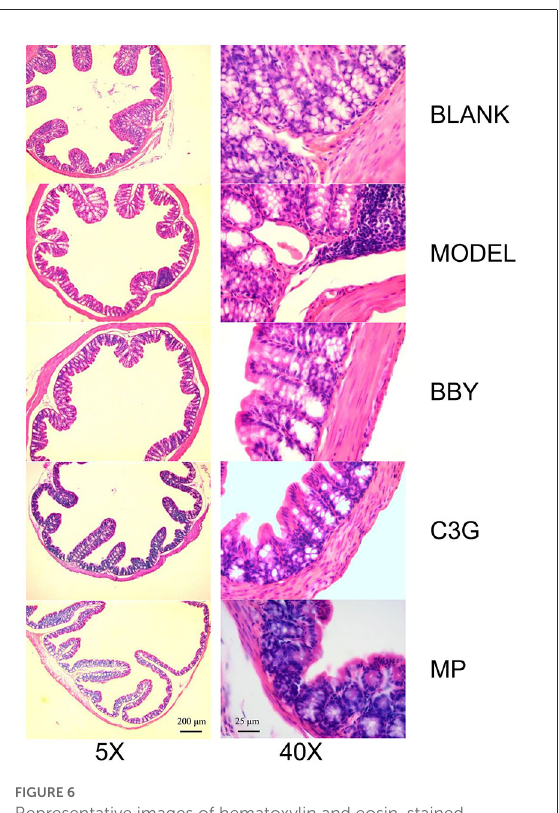
FIGURE6 Representative images of hematoxylin and eosin-stained colonic sections under 5X (left) and 40X